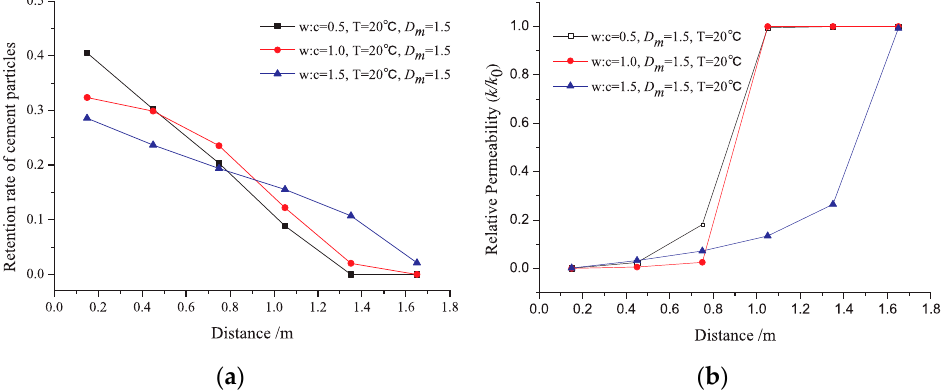
Figure 4. Basic law of grouting migration (initial permeability 5D, grouting pressure 2 MPa, and water–cement ratio 1.0). Panel ( a ) displays the molarity distribution characteristics of grouting materials at different times; ( b ) displays the viscosity distribution characteristics of grouting mate- rials at different times; ( c ) displays the permeability coefficient distribution characteristics of grouting materials at different times; ( d ) displays the grouting radius and range of transition re- gion of grouting materials at different times; ( e ) displays the molarity contour surface of grouting material migration for 40 min.